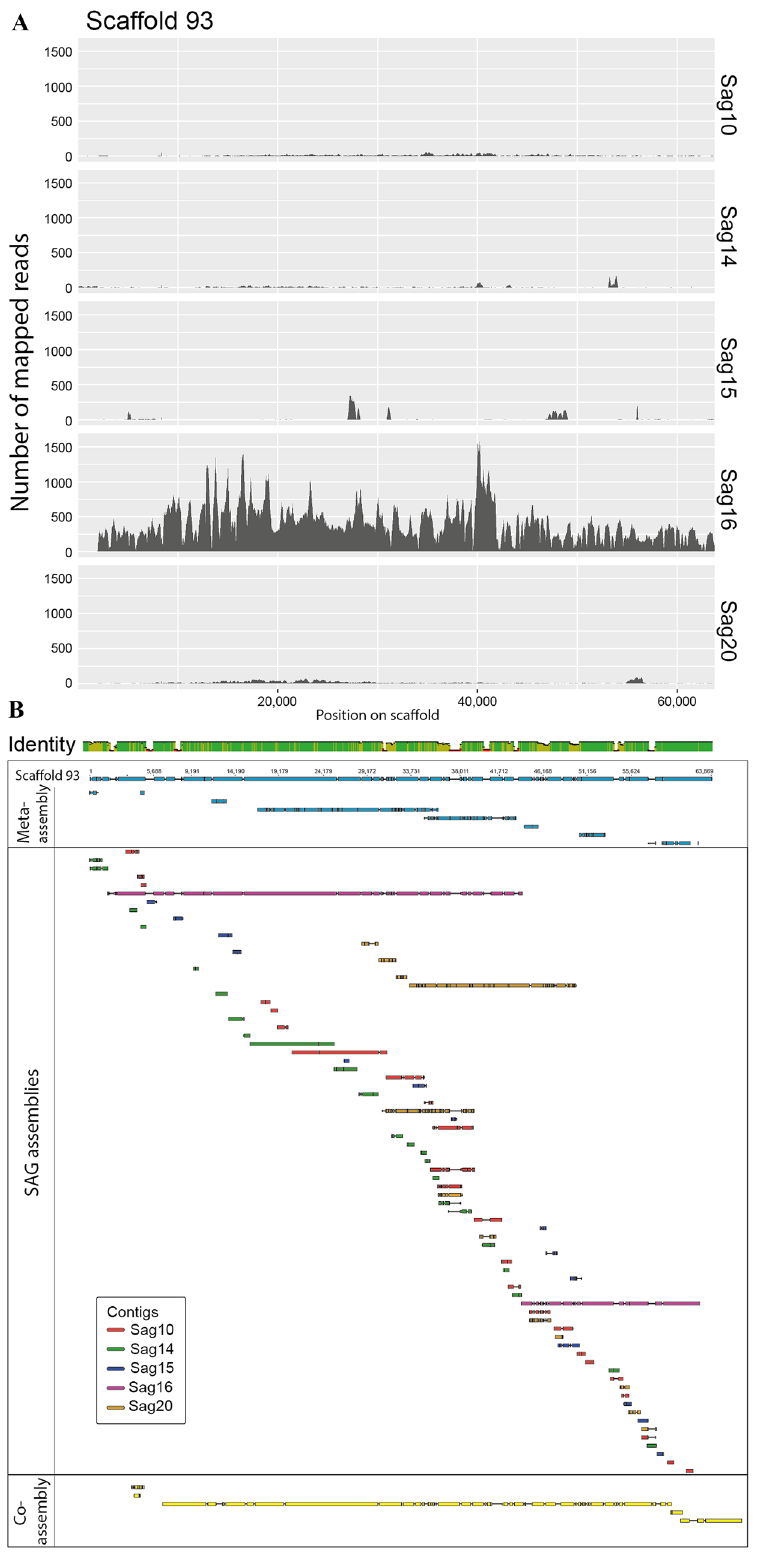
Figure 6. Genome coverage and alignment of contigs to scaffold 93 in the meta-assembly. ( A ) Mapped Illumina reads from each SAG library to scaffold 93 from the meta-assembly. ( B ) An alignment of the contigs from the SAG assemblies against scaffold 93. The alignment also contains contigs from the co-assembly aligned to the same scaffold. This scaffold represents a portion of the genome almost exclusively amplified in SAG16. See also the description in the text. Plots created with the ggplot2 42 R package and Geneious Prime 2019.2 (www. genei ous.